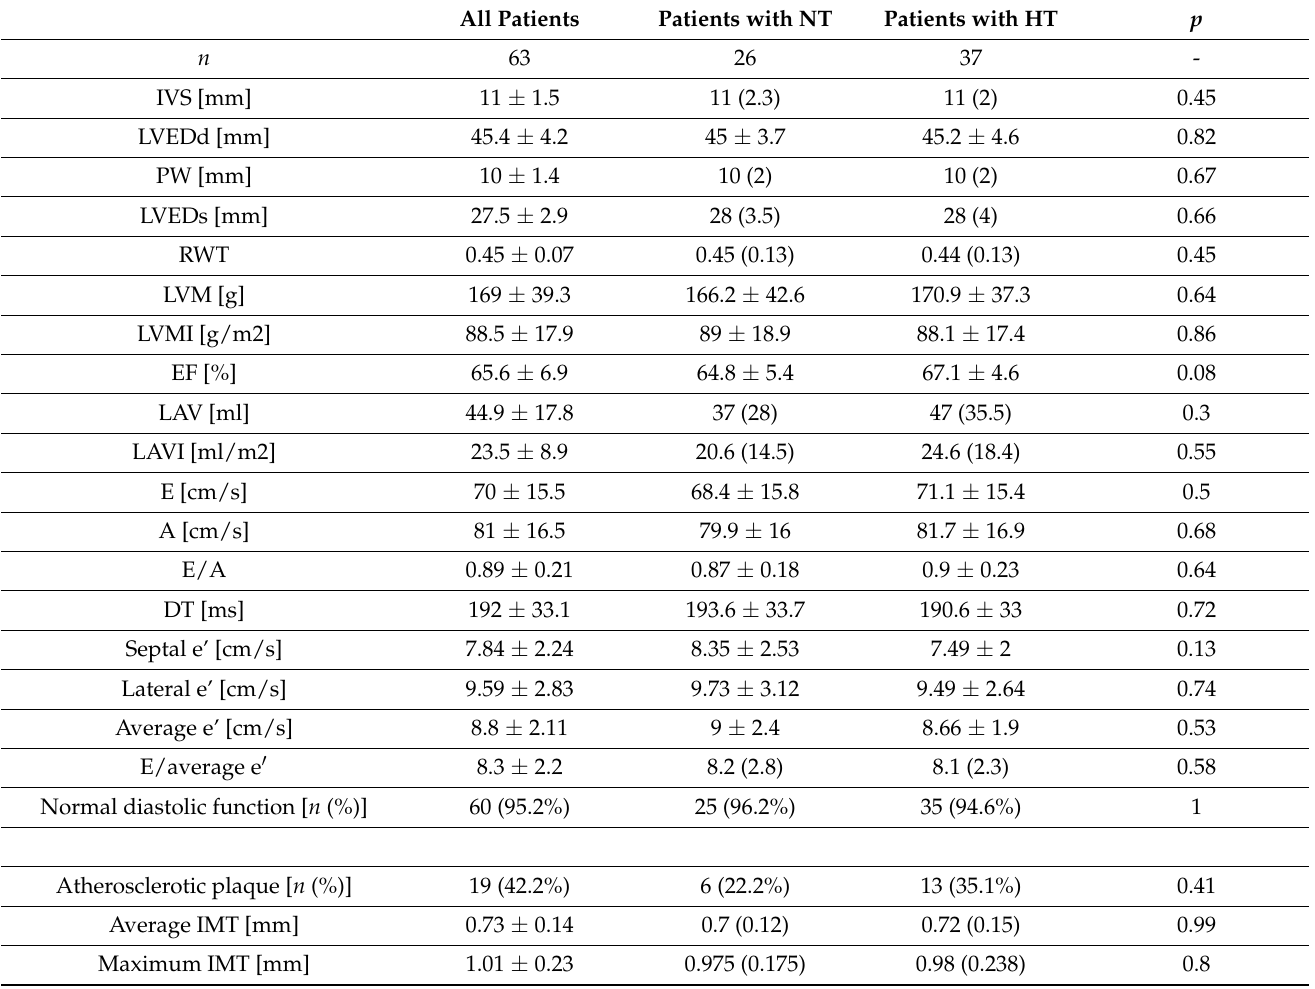
Table 3. Echocardiographic and carotid artery intima-media complex